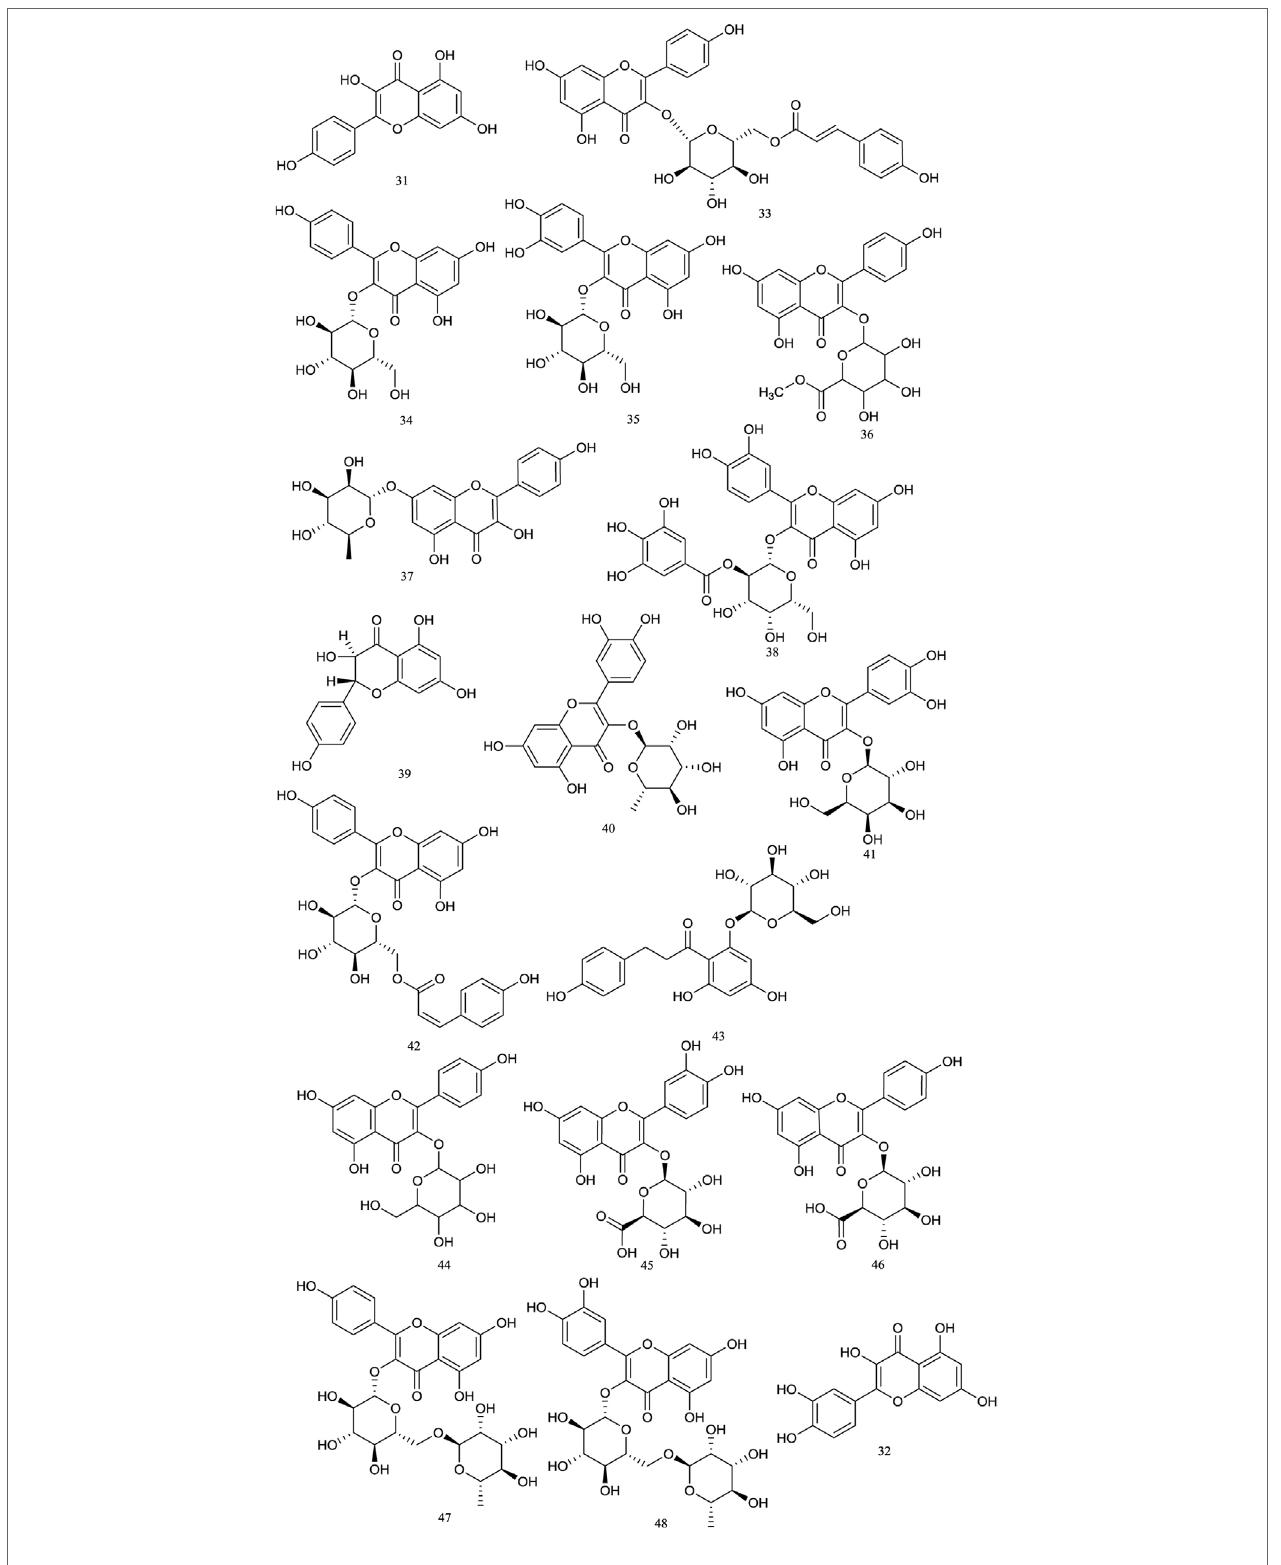
FIGURE 3 | Chemical structures of flavonoids (31–48) isolated from R. chingii